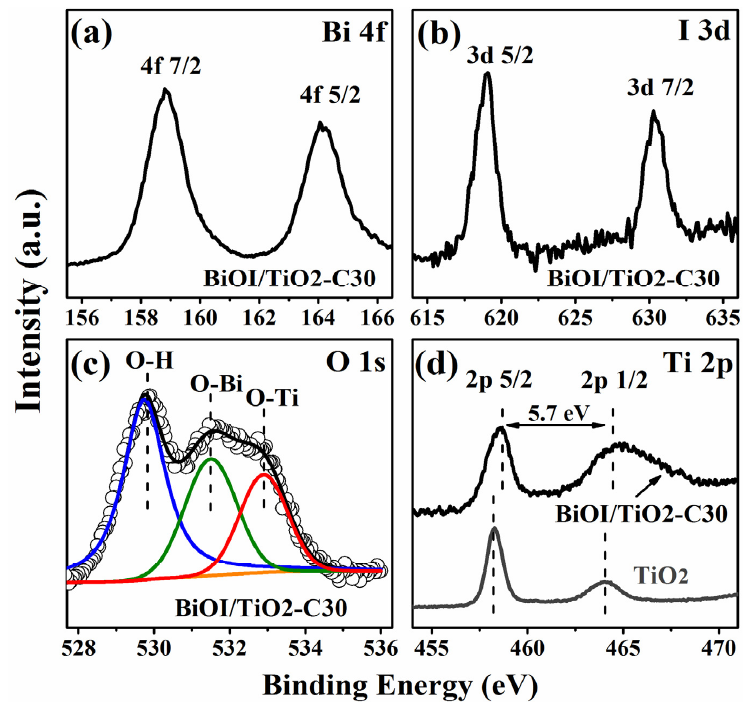
Figure 4. ( a ) XPS spectra of Bi 4f; ( b ) I 3d; and ( c ) O 1s for BiOI/TiO 2 ‐ C30; ( d ) XPS spectra of Ti 2p for TiO 2 nanofibers (bottom) and BiOI/TiO 2 ‐ C30 (top).